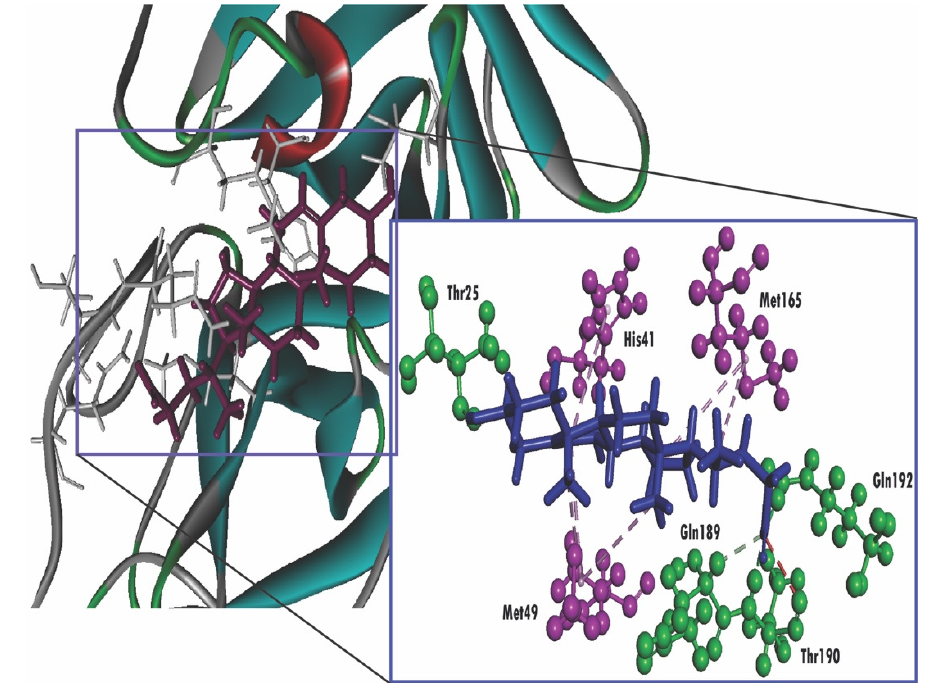
Figure 5. Molecular docking interaction between the SARS-CoV-2 M pro and 3.beta-Hydroxy-5-cholen-24-oic acid ligand in the active site is shown in purple color, and ligand interacting with the residues is shown in blue color, green color illustrates the residues forming hydrogen bonds, pink color illustrates the residues with hydrophobic (pi-pi / pi-alkyl) stacking, and white color illustrates the residues with carbon-hydrogen interaction.